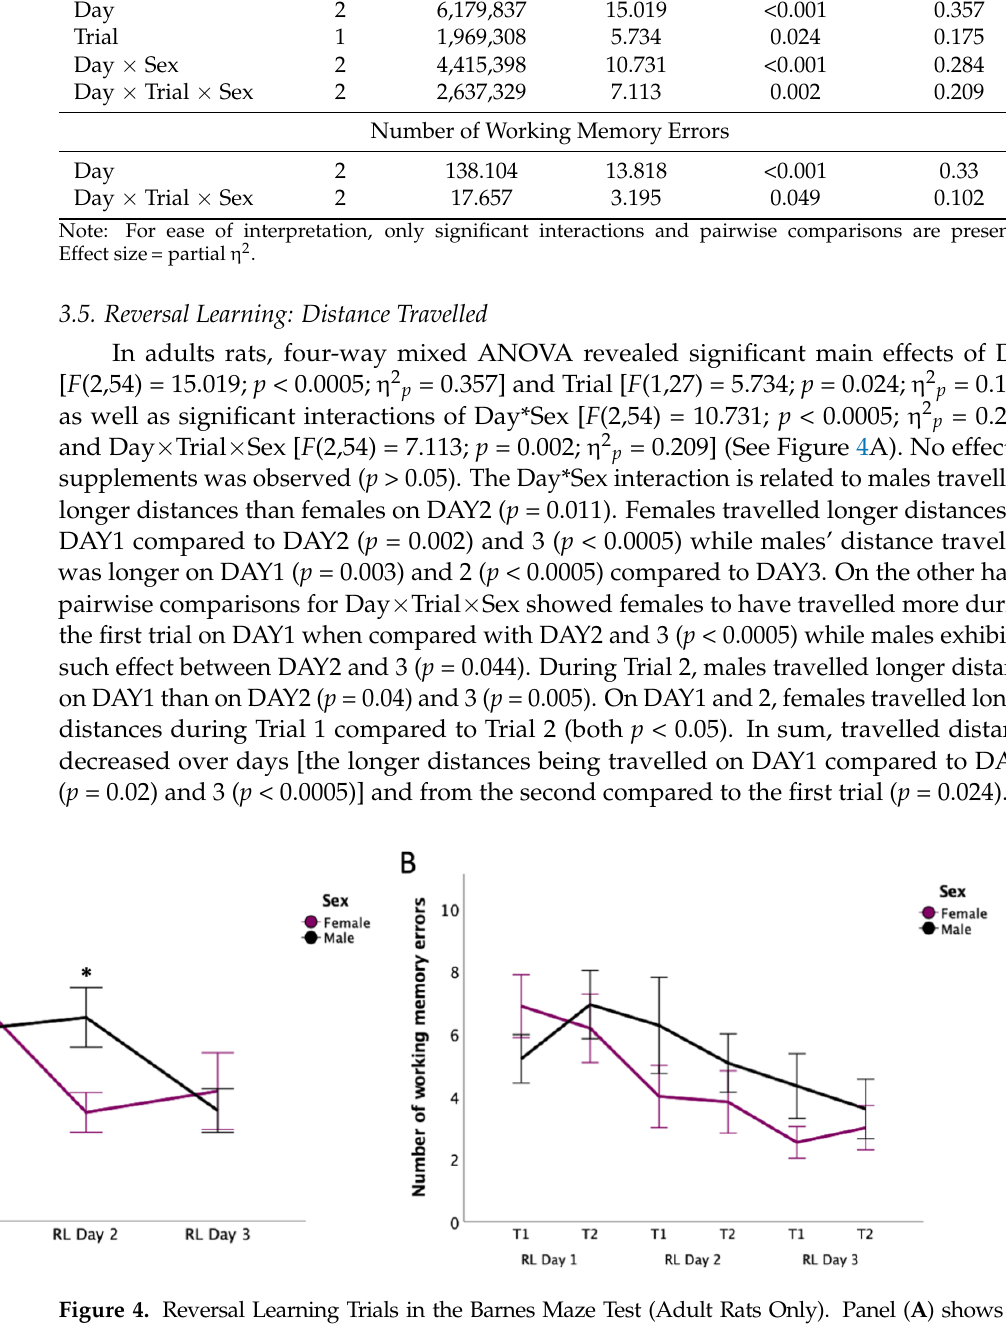
Figure 4. Reversal Learning Trials in the Barnes Maze Test (Adult Rats Only). Panel ( A ) shows the distance travelled (cm) for males and females during the 3 days of reversal learning. Panel ( B ) presents the number of working memory errors in male and female rats. Data are presented as mean ± S.E.M. * Indicates statistically significant difference between groups at p < 0.05. No effect of the supplementation was observed. RL: Reversal learning; T1: Trial 1; T2: Trial 2.